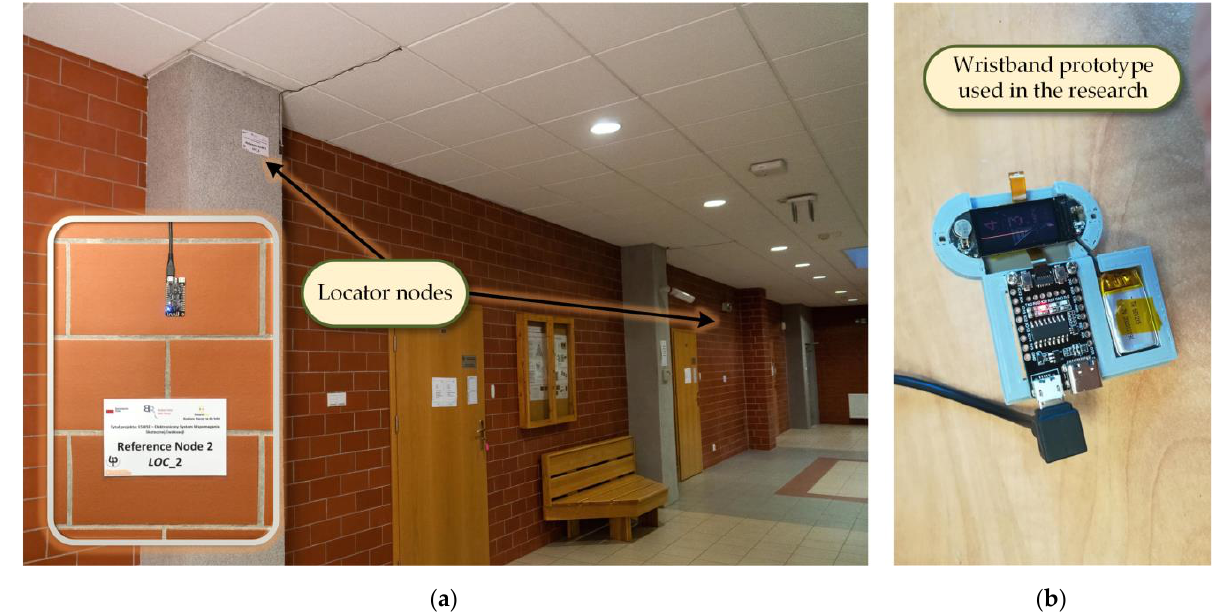
Figure 1. ( a ) The locator node (receiver). ( b ) The wristband module (transmitter) connected to the programmer.